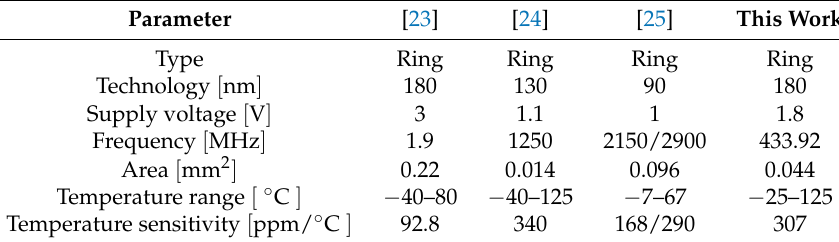
Figure 10. The measured output frequency of the VCO. Table 1. Performance summary of the VCO temperature